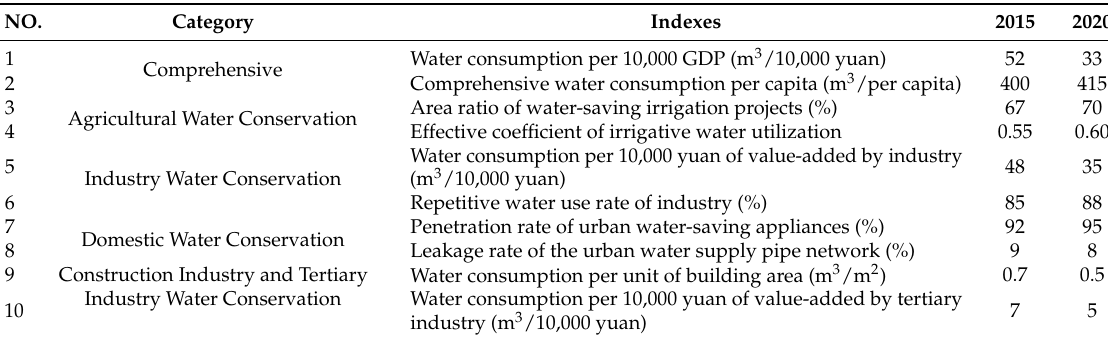
Table 1. Initial values of water efficiency indexes in 2015 and 2020 in